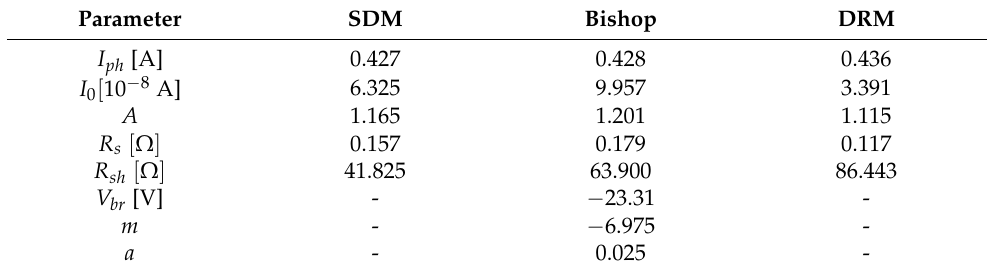
Table 6. Parameters used for the best